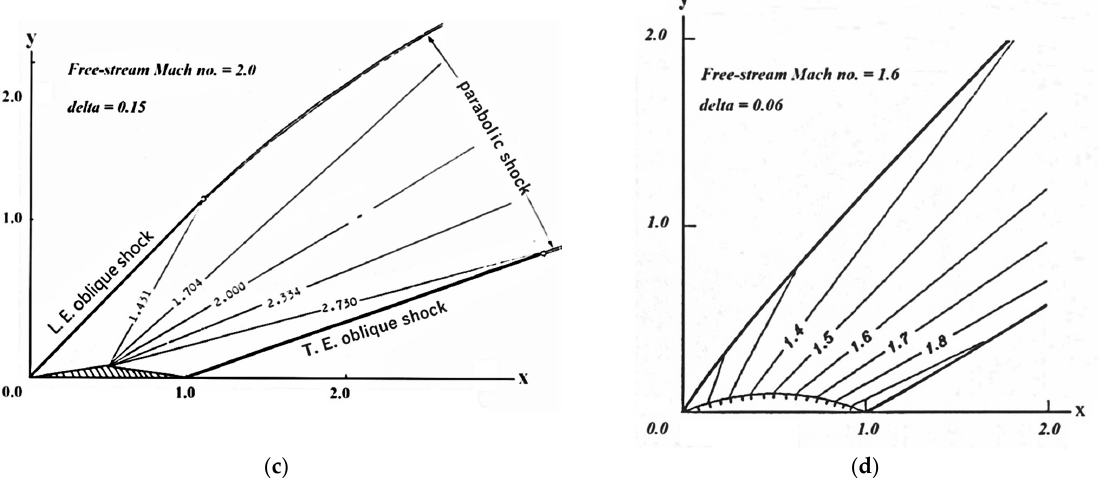
Figure 2. Examples of supersonic far field flows: ( a ) Iso-Mach lines of Prandtl–Meyer (expansion fan) flow, ( b ) oblique shock of a concave corner flow, ( c ) iso-Mach lines and shock waves of a double-wedge airfoil with δ = 0.15 and M ∞ = 2.0, and ( d ) iso-Mach lines and shock waves of a parabolic airfoil with δ = 0.06 and M (cid:2998) = 1.6.